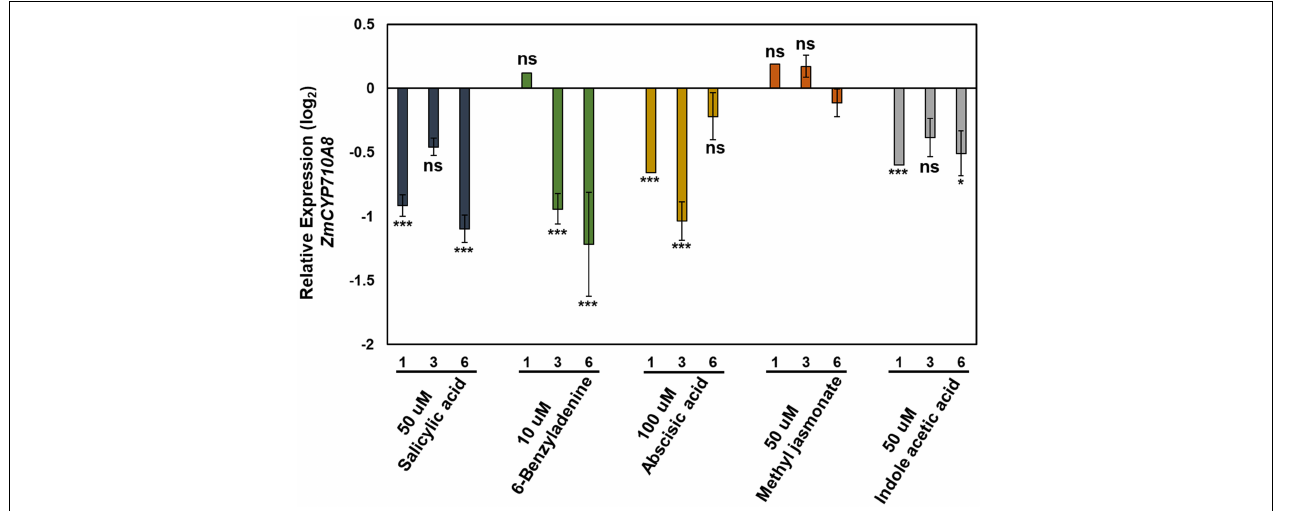
FIGURE 4 | Relative expression of ZmCYP710A8 mRNA in response to hormone treatments. Relative mRNA levels (log 2 ) of ZmCYP710A8 compared to mock in response to various hormone treatments for indicated hours after treatment. Leaf tissues (leaf 2) from three plants were pooled for one time point (as indicated) per treatment. mRNA levels were measured in triplicates with ZmACTIN was used as a reference gene for normalization. Data are means ± SE from two independent experiments. Asterisks indicate statistical significance by Students t -test compared to mock samples at their respective time points. * P < 0.05; *** P < 0.001; ns,